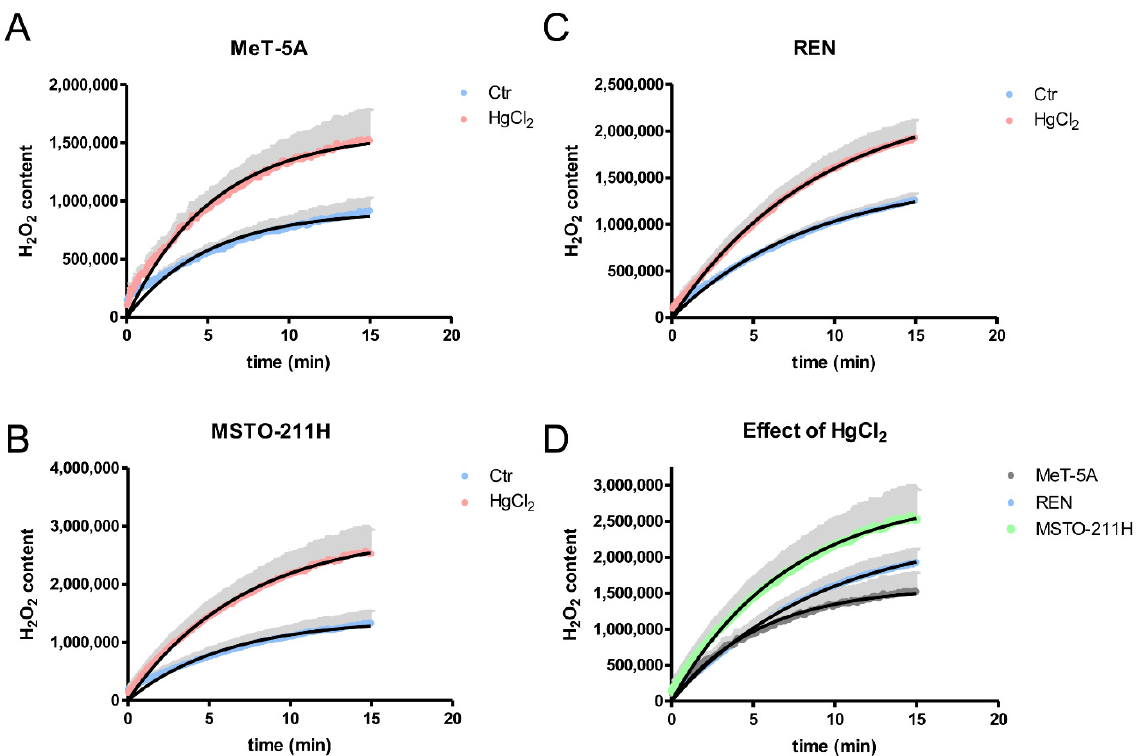
Figure 6. Effect of mercury chloride (HgCl 2 ) treatment on the hydrogen peroxide permeability of mesothelial (MeT-5A; A ), epithelioid (REN; B ), and biphasic (MSTO-211H; C ) MPM cell lines. ( D ) shows the compared effect of HgCl 2 on hydrogen peroxide permeability in three cell lines. Hydrogen peroxide permeability was measured by loading the cells with CM-H 2 DCFDA reagent as described in Materials and Methods. Curves represent the time course of H 2 O 2 transport, expressed as H 2 O 2 content. Values are mean ± SEM (in gray) of three-time courses for each of four different experiments. Ctr, controls ( A–C ) p < 0.0001 (Student’s t -test). ( D ) Y max values obtained by one-phase exponential association were (Mean ± SEM): Met-5A, 1.59 × 10 6 ± 2.3 × 10 4 ; REN, 2.39 × 10 6 ± 4.2 ×